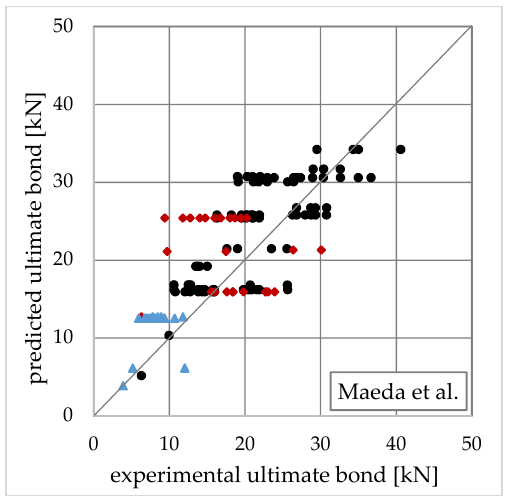
Figure 4. Test vs. predicted bond force using the Maeda et al. model [16].